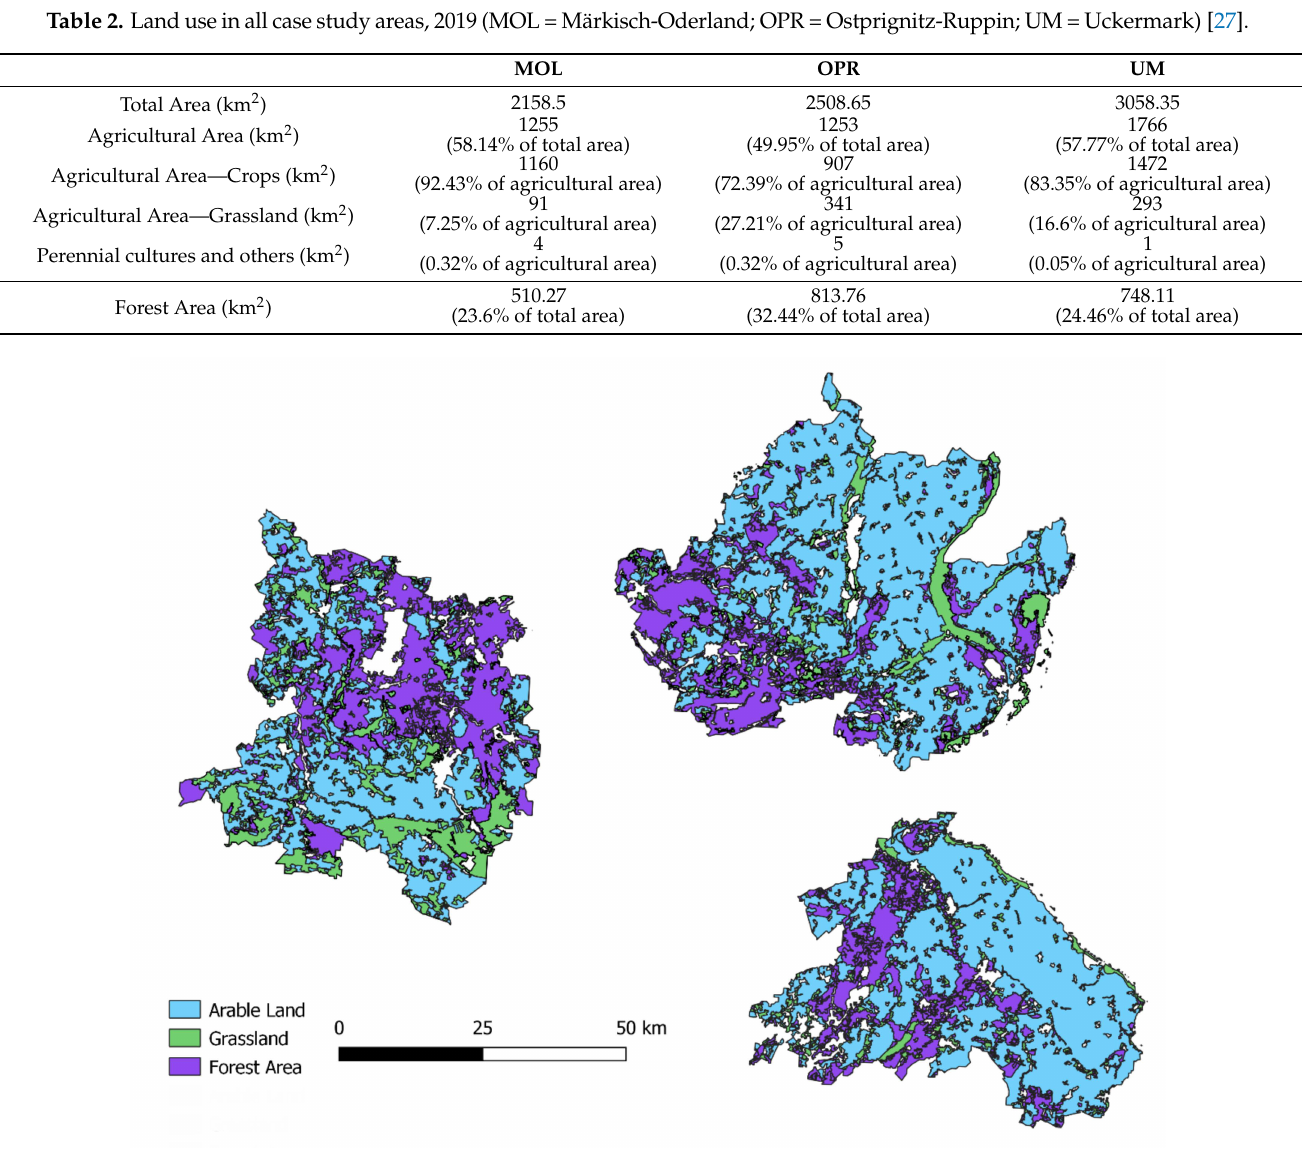
Figure 1. Land use in all case study